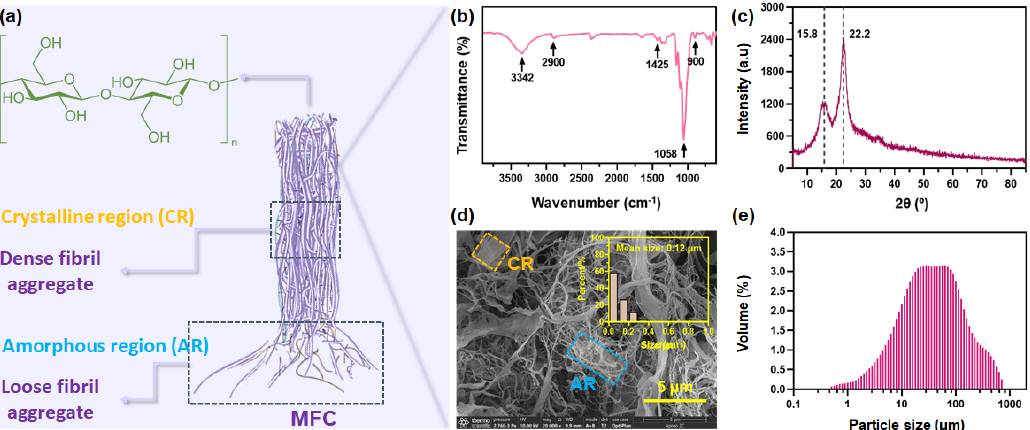
Figure 1. Schematic illustration ( a ) with permission from Springer 2019 [34], FTIR spectrum ( b ), XRD spectrum ( c ), SEM image ( d ) and particle size ( e ) of microfibrillated cellulose (MFC).